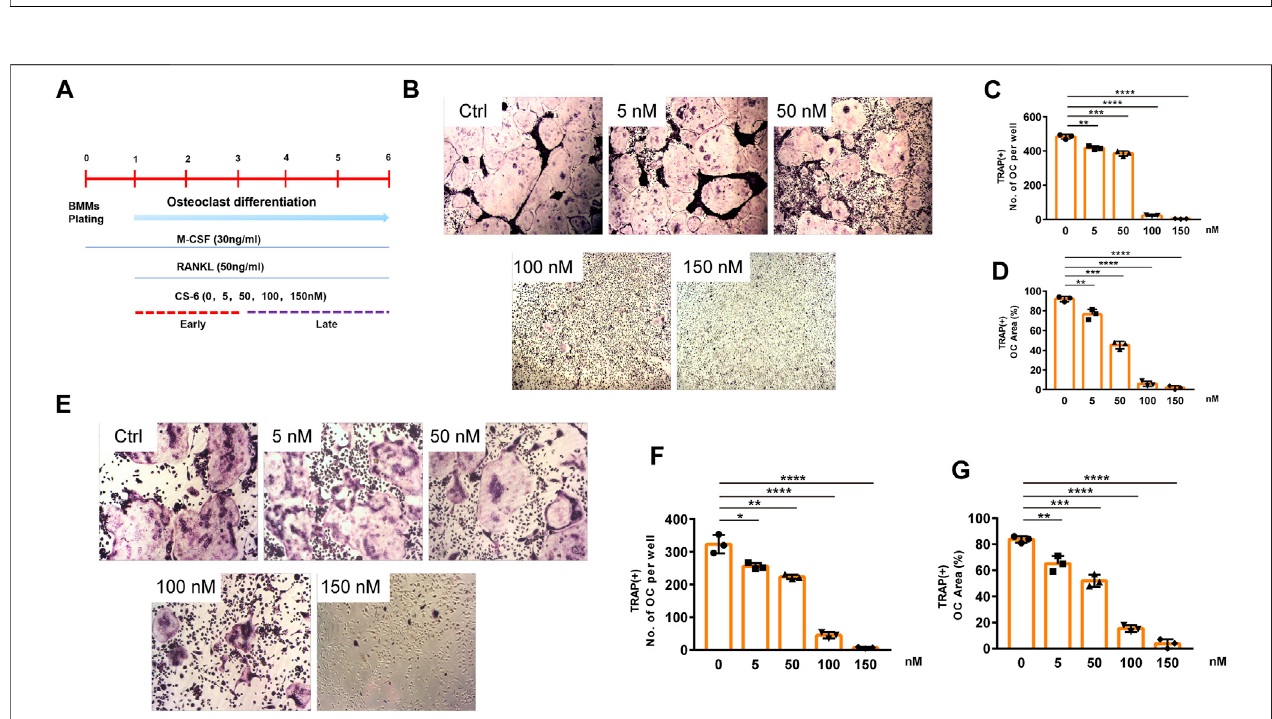
FIGURE 2 | CS-6 inhibited RANKL-induced OC differentiation in vitro in both the early and late stages of osteoclastogenesis. (A) The illustration of experimental design regarding early and late stimulation by CS-6. (B) Representative images of TRAP staining – positive OCs stimulated by RANKL (50 ng/ml) with indicated concentrationsofCS-6for5 – 7 days.The (C) numberandcellspreadarea (D) ofTRAP + multinucleatedOCswereshownasgraphs. (E) RepresentativeimagesofTRAP staining – positive OCs stimulated with RANKL (50 ng/ml) for 3 days prior to indicated concentrations of CS-6. The (F) number and cell spread area (G) of TRAP + multinucleated OCs were presented as graphs. Values were shown as the mean ± standard deviation ( n (cid:2) 3); * p < 0.05, ** p < 0.01, *** p < 0.001, **** p < 0.0001.